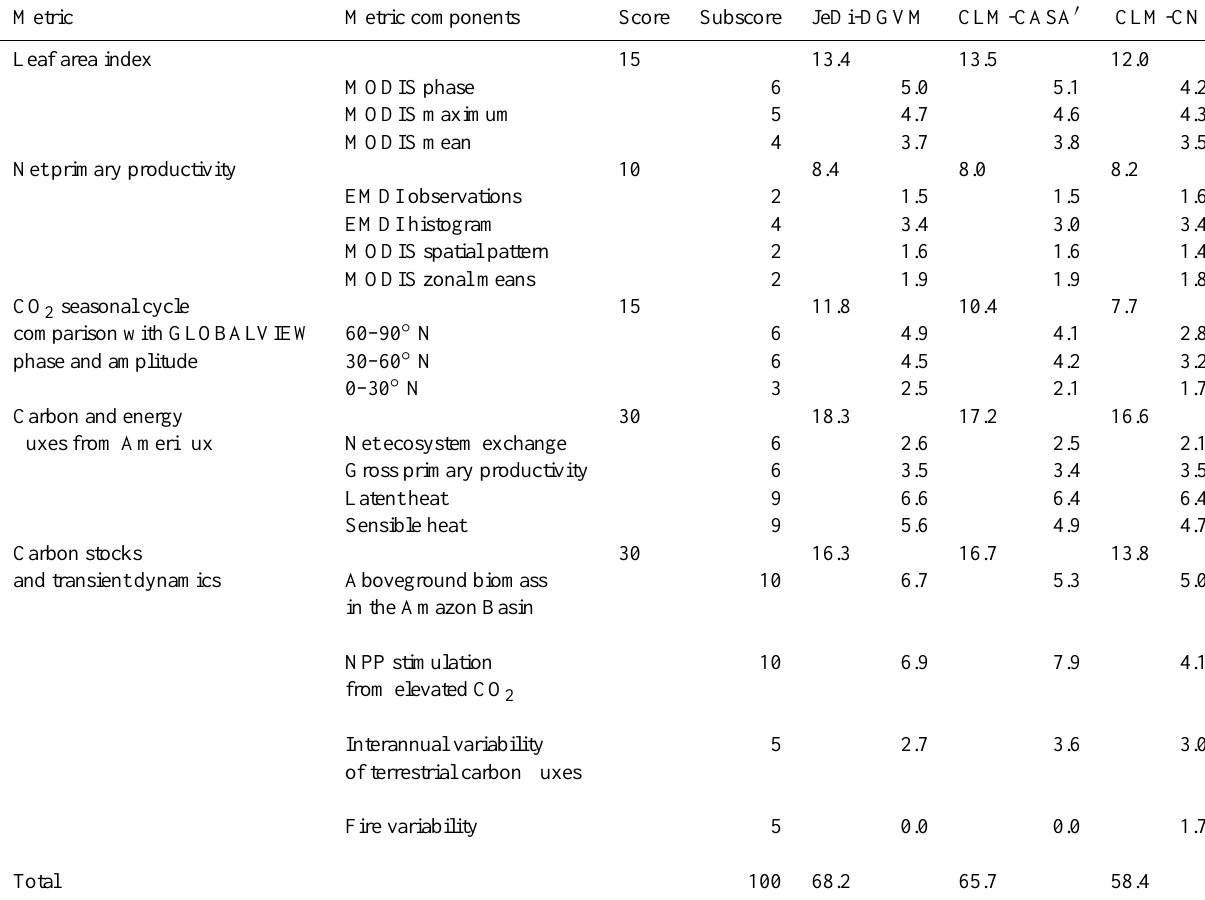
Table 1. Summary of the evaluation metrics and scores. Each metric (column 1) is associated with a possible score (column 3) based on a subjective assessment of its level of uncertainty and model–data scale mismatch. Each metric is broken into metric components (column 2) with associated subscores (column 4). Scores are presented for JeDi-DGVM (this paper) and, for comparison, CLM-CN and CLM-CASA 0 (previouly evaluated in Randerson et al., 2009). The total score for each model (out of a possible score of 100) is presented at the bottom. MODIS, MODerate Resolution Imaging Spectroradiometer; EMDI, Ecosystem Model–Data